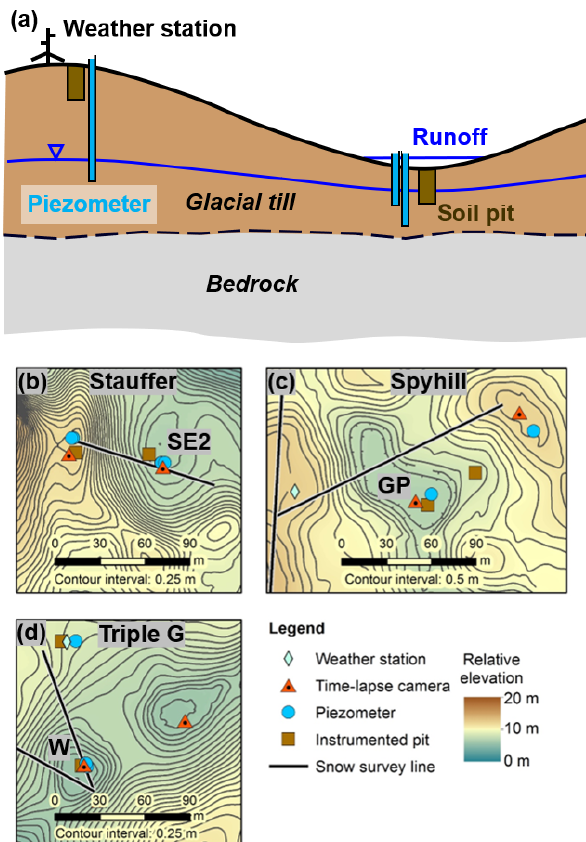
Figure 2. Conceptual cross section of instrumentation at the study sites (a) . Plan views of instrumentation and relative elevations of (b) SE2 at the Stauffer site, (c) GP at the Spyhill site, and (d) W at the Triple G